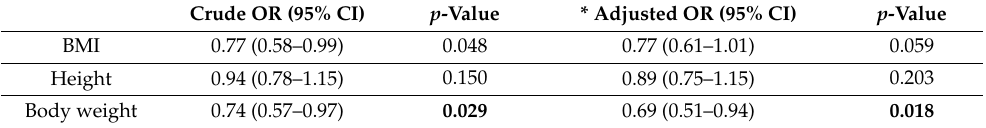
Table 1. Impact of BMI, height, and body weight on cardioversion success. Crude OR (95%